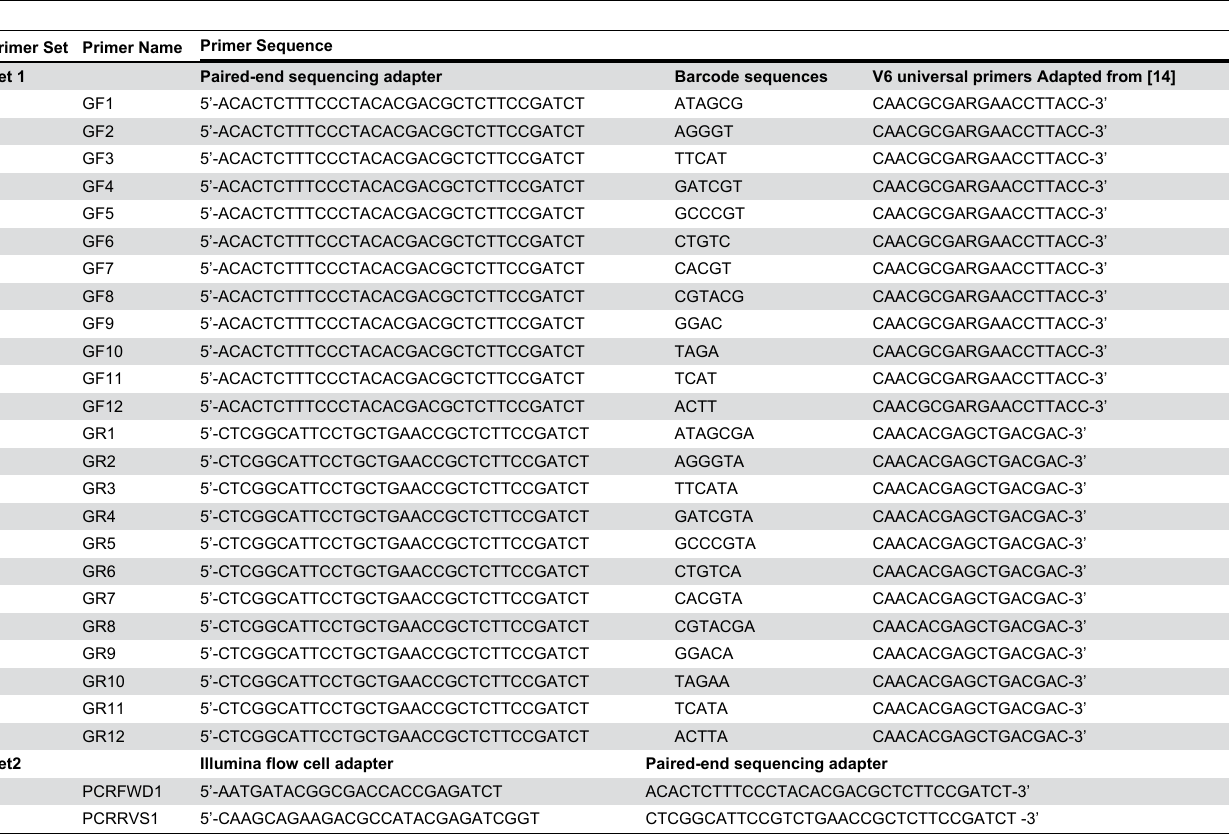
Table 1. Sequence of polymerase chain reaction (PCR) primers used for construction of the Illumina library.